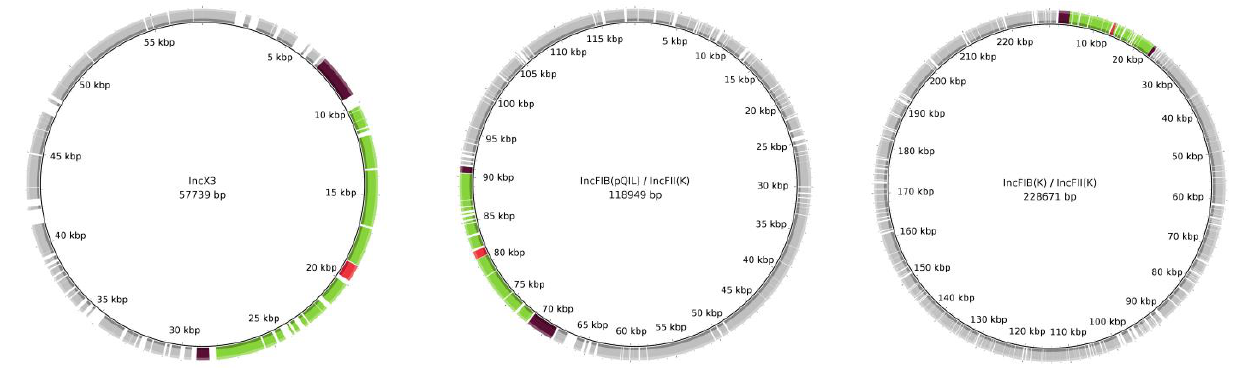
Figure 2. Circular map representing the complete sequence of IncX3, IncFIB(pQIL)/IncFII(K), and IncFIB(K)/IncFII(K) plasmids in BAT16 KPC-producing Klebsiella pneumoniae isolate. The backbone sequence is shown in gray. IS 3000 and IS 26 elements flanking the transposed region are shown in brown. The transposed region is shown in green. bla KPC-3 gene is shown in red.